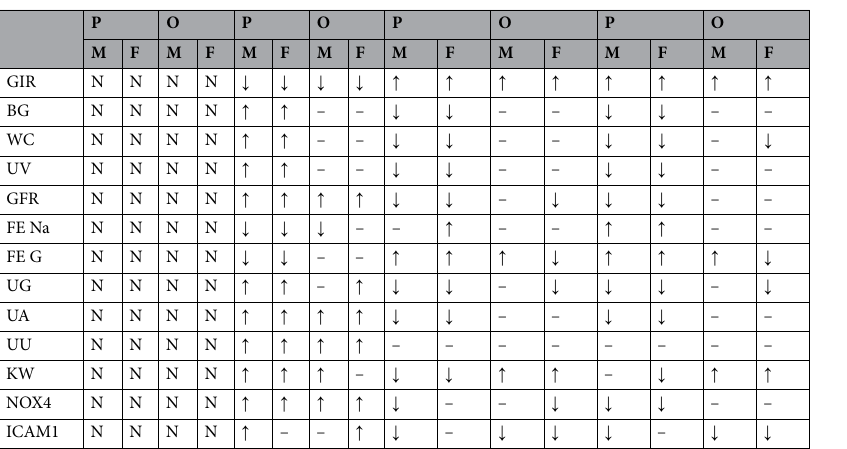
Table 2. Summery of the resells. ↑ : Increase, ↑ : Decrease, –: No change, N: normal. P Parents, O Offspring, GIR Glucose infusion rate, BG Blood glucose, WC Water consumption, UV Urine volume, FE Na Sodium fraction excretion rate, FE G Glucose fraction excretion rate, UG Urine glucose, UA Urinary albumin, UU Urinary urea, KW Kidney